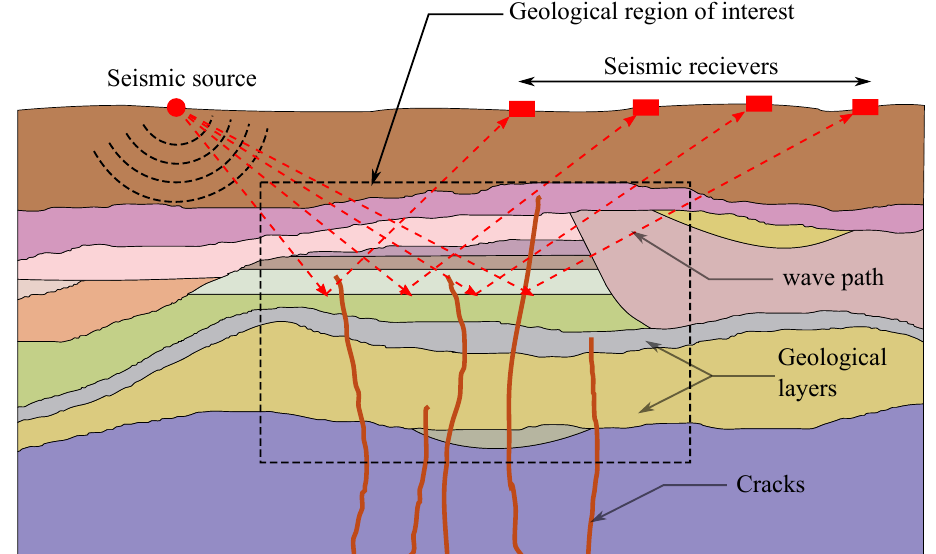
Figure 1. A schematic representation of geophysical investigation using seismic waveform inversion of a subsurface geological region with multiple